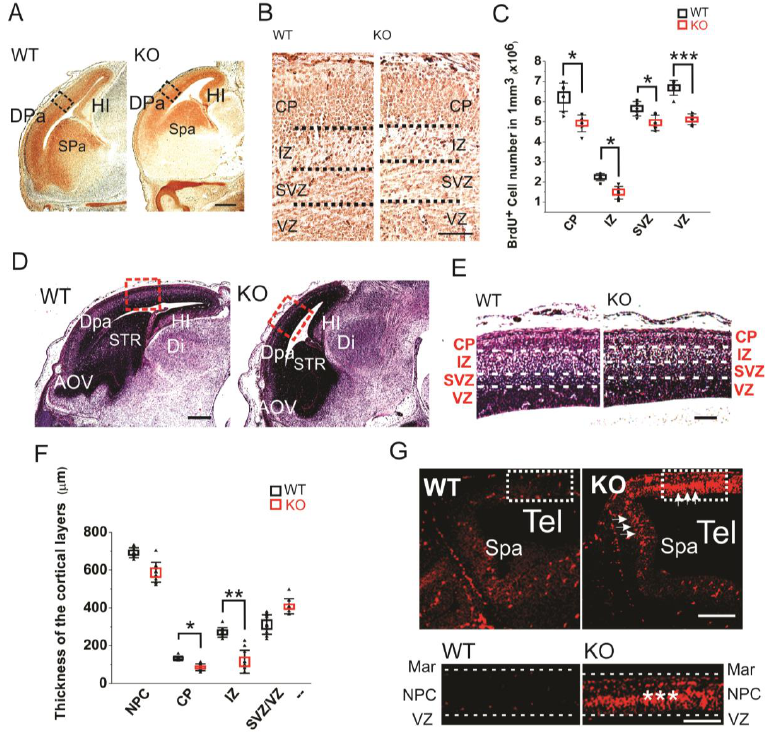
Figure 2. ( A ) Sagittal sections of E16 embryos with BrdU staining. Scale bar indicates 500 µm. The black rectangles are the areas shown in B. ( B ) BrdU staining of E16 dorsal telencephalon under higher resolution. Scale bar indicates 100 µm. ( C ) Statistics of the BrdU + cell numbers in the E16 cortical layers of the KO and WT embryos. For each brain, BrdU + cell numbers in each layer were counted five times at different sections for averaging. The stained sections from 5 KO and 5 WT embryos were used for comparison. Mean values ± S.D. (error bars) and S.E.M (Boxes) are indicated ( n = 5; *** p < 0.001; * p < 0.05, unpaired t- test, two-tailed). ( D ) Sagittal sections of E16 embryos with hematoxylin staining. The areas in red rectangle were zoomed out in ( E ) Scale bar indicates 500 µm. ( E ) The E16 cortical layers in the dorsal pallium (Dpa) with hematoxylin stains. Scale bar indicates 150 µm. ( F ) Statistics of the thickness of E16 cortical layers. Each layer has been measured on three different sections at central position for each embryo. Sections from six KO and six WT mice have been measured. Mean values ± S.D. (error bars) and S.E.M (Boxes) are indicated ( n = 6; **, p < 0.01; *, p < 0.05, unpaired t -test, two-tailed). ( G ) The Tunel staining of E12 sagittal sections. The strong apoptotic signaling in the dorsal neopallial cortex (NPC) and subpallium (Spa) of the HMGB1 KO is indicated by white arrows. The area in the white rectangle has been amplified. The intermediate layer of NPC showed highest apoptotic activity (***). Scale bar indicates 200 µm in the upper panel and 100 µm in the lower panel. Abbreviations: AOV, ventral anterior olfactory area; CP, cortical plate; Dpa, dorsal pallium/isocortex; H, hindbrain; HI, hippocampus; IZ, intermediate zone; M, midbrain; MAR, marginal layer; NPC, neopallial cortex; Spa, subpallium; STR, striatum; SVZ, subventricular zone; Tel, telencephalic vesicle; VD, ventricles of diencephalon; VZ, ventricular zone.